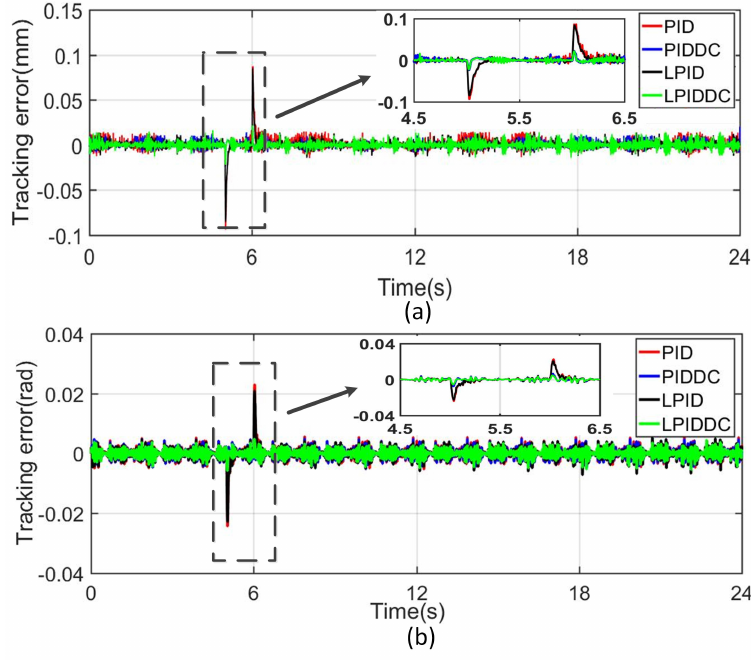
Figure 5. Tracking results of Track1 and Track2 with step disturbance. ( a ) Tracking error in s z -axis. ( b ) Tracking error in s γ